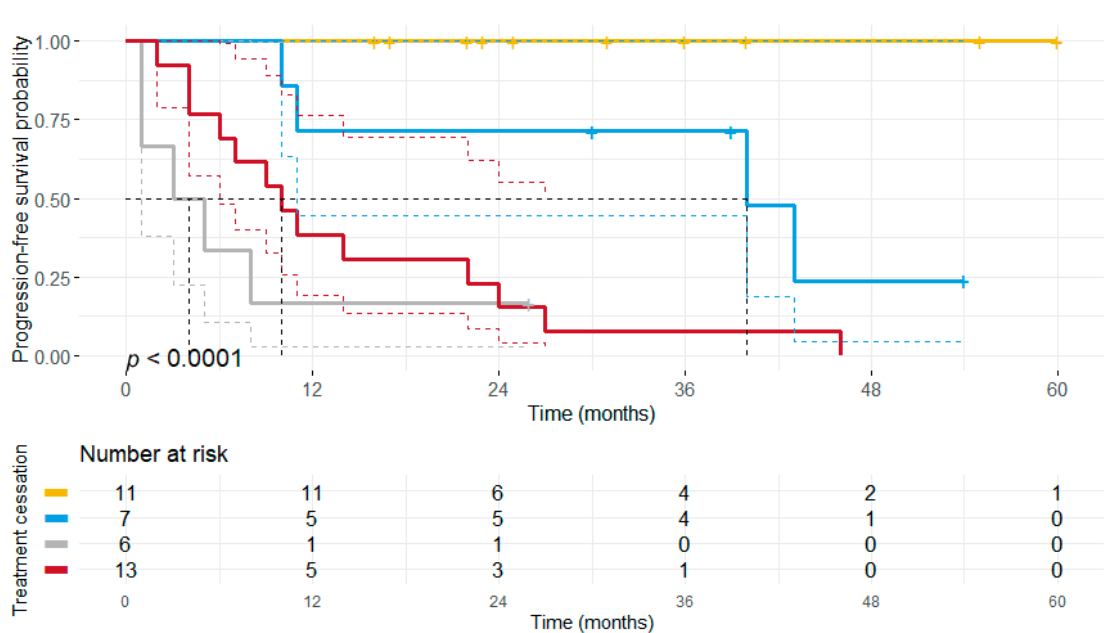
Figure 5. Kaplan-Meier plot illustrating the progression-free survival separated by the reasons for treatment discontinuation. Patients who terminated BRAF ± MEKi therapy due to toxicity or disease progression had a significantly shorter PFS (median PFS: 3 months vs. 10 months) compared to patients with ongoing treatment (median PFS not reached, p < 0.0001) or treatment discontinuation due to other reasons (termed as physician’s choice) (median PFS: 40 months, p = 0.013).